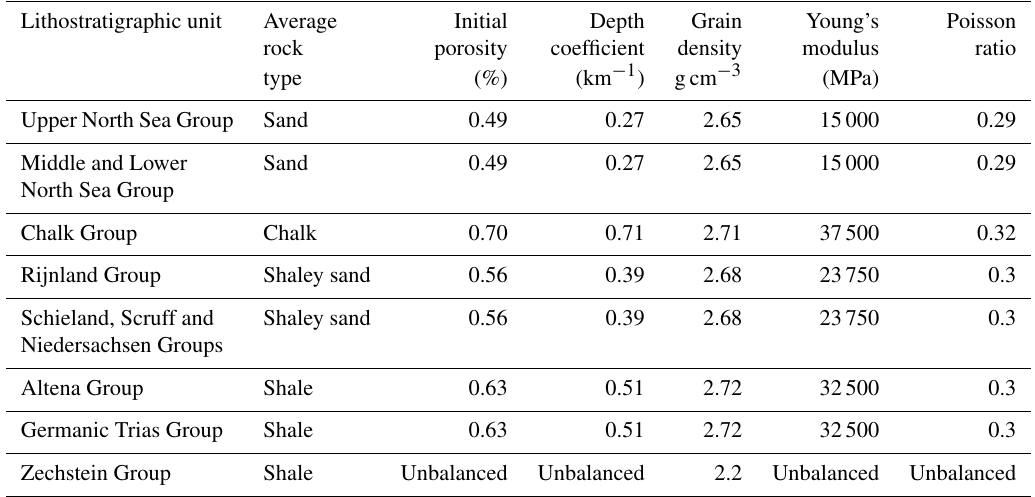
Table 1. Model rock properties based on stratigraphy and rock type (Sclater and Christie, 1980; Hunfeld et al., 2021). Average rock type always assigned as 100% of unit. All pores assumed to have been filled with water. Lithostratigraphic unit Average Initial Depth